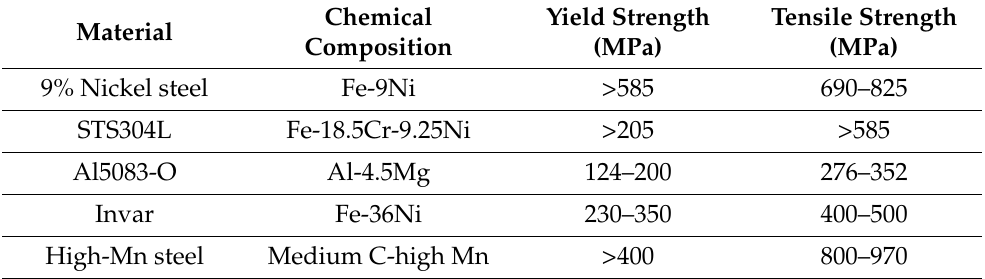
Table 1. Materials for cryogenic fuels listed in the IGC